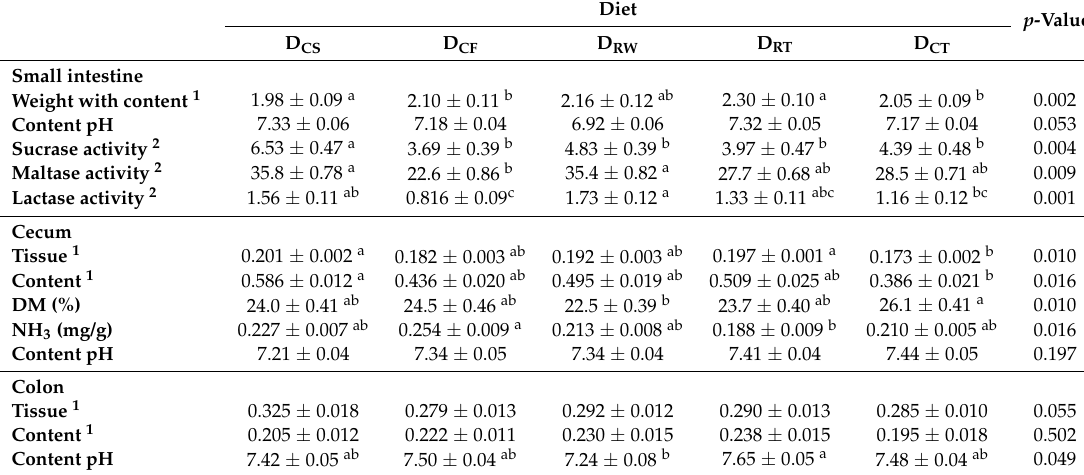
Table 1. Parameters of the small intestine, cecum, and colon of rats fed experimental diets. Data are expressed as mean ± SEM, n =